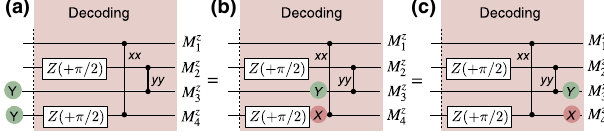
FIG. 14. Detection of the dangerous two-qubit errors in the DiVincenzo-Aliferis-type scheme: The circuits show how an Y incoming Y error, resulting from the transversal-coupling a 3 a 4 step in Fig. 13, results in bit flips ( Y and X ) on the third and a 3 a 4 fourth ancilla qubits. However, in this case, the third and fourth qubits end up in j 0 i and j 1 i , respectively, which results in an a 3 a 4 M z 3 ¼ þ 1 ; M z 4 ¼ − 1 measurement